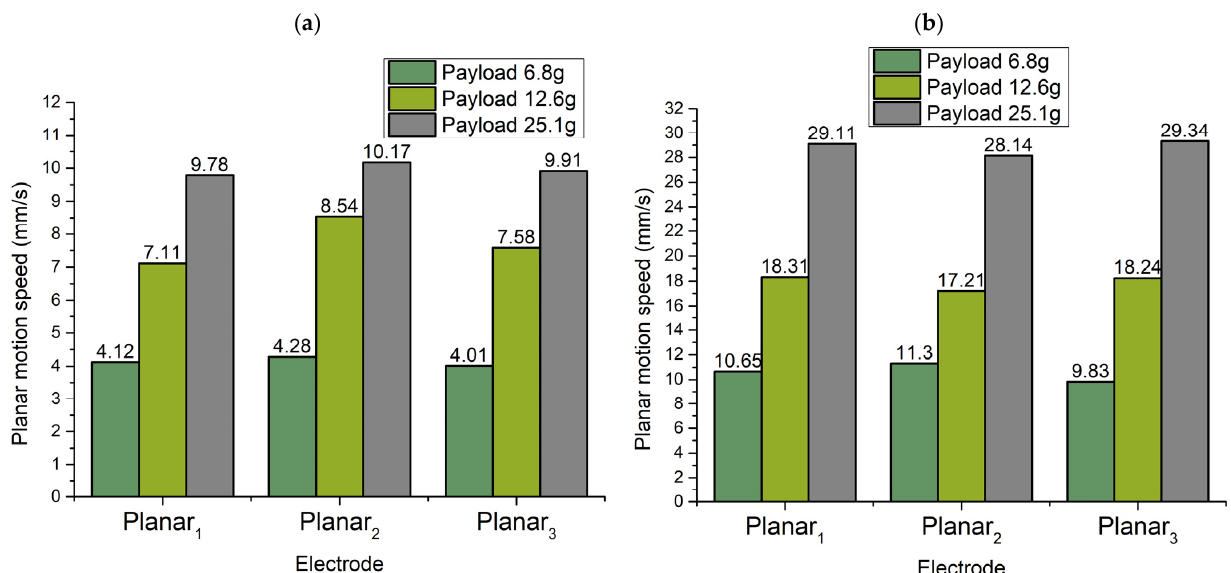
Figure 17. Summary of minimum and maximum planar motion speeds while different payloads are applied to the robot; ( a )—minimum planar motion speeds while different payloads are used; ( b )—maximum planar motion speeds while different payloads are used.